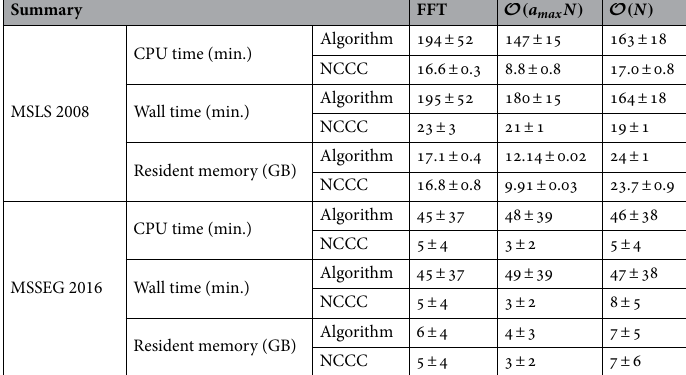
Table 1. Summary of computational analysis over real MRI database.